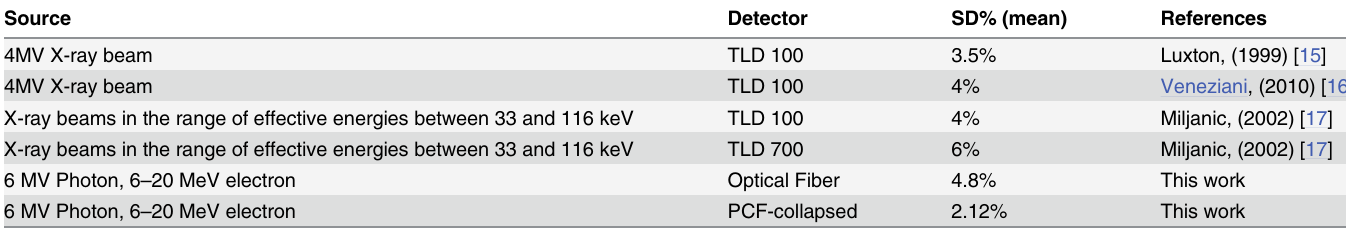
Table 3. Comparison of SD values of clinically used dosimeters with the studied silica based dosimeter.